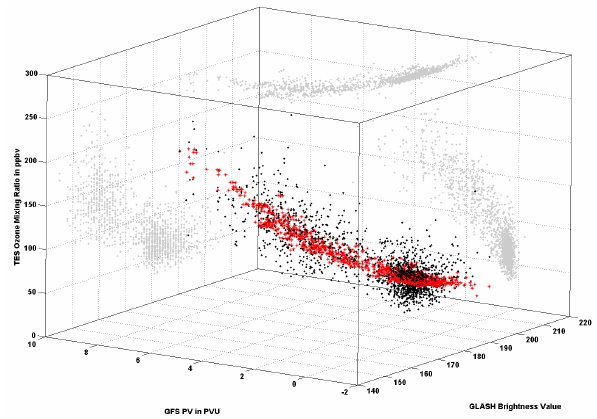
Fig. 4. 3-D plot of layer average UT ozone (as observed by TES) vs. corresponding GLASH brightness value and layer average UT GFS PV value. Observations are plotted as black dots, while predicted regression values (multiple-linear in the form of a plane) are plotted in red. Observations are projected (in light grey) on to each axis for easier